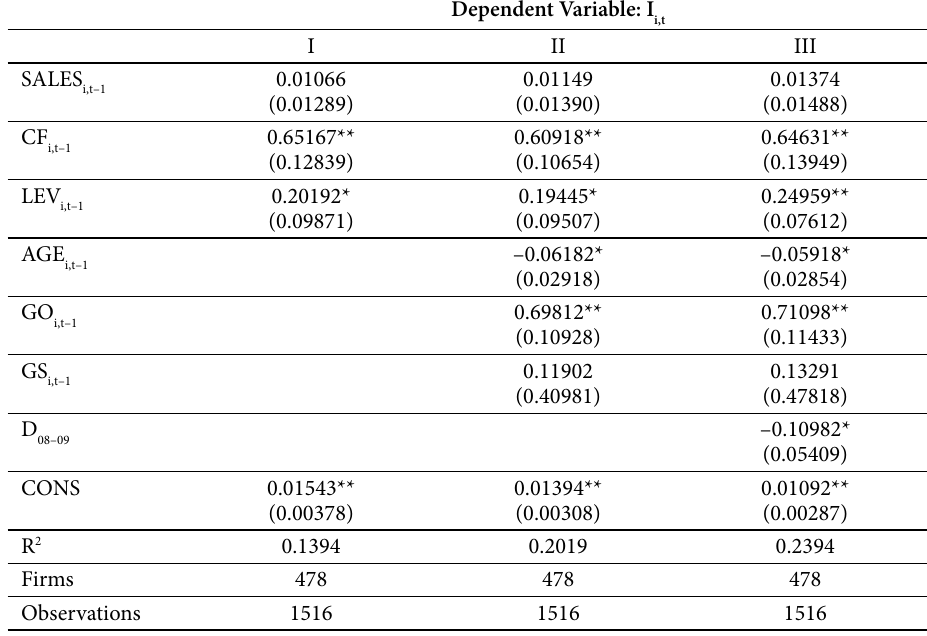
Table 7. investment determinants of manufacturing